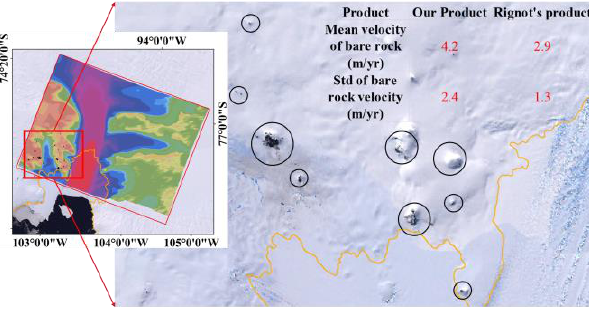
Figure 6 . Distribution and parameter statistics of rock outcrop in PIG. The black circle represents the distribution of rock outcrop. The table at the top right counts the annual average velocity and standard deviation of rock outcrop of our product and Rignot’s (Mouginot et al.,